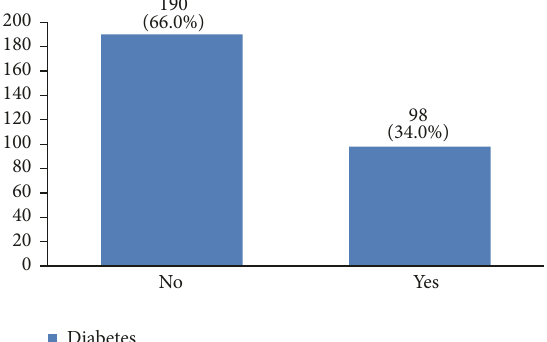
Figure 18: The number of removed lymph nodes in the studied